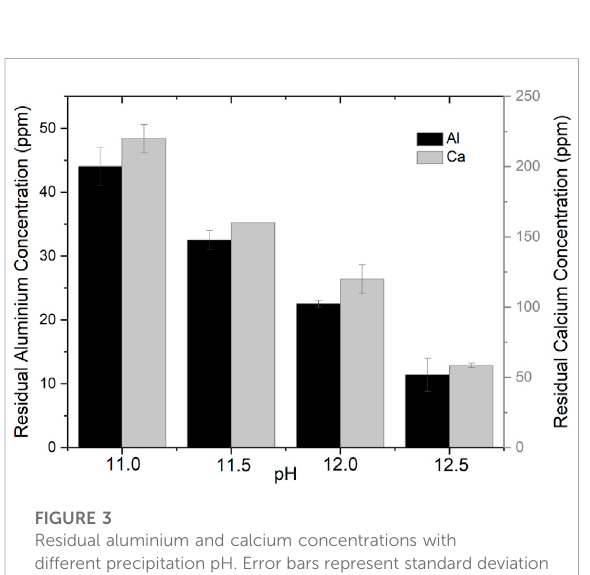
FIGURE 3 Residual aluminium and calcium concentrations with different precipitation pH. Error bars represent standard deviation ( n = 2).